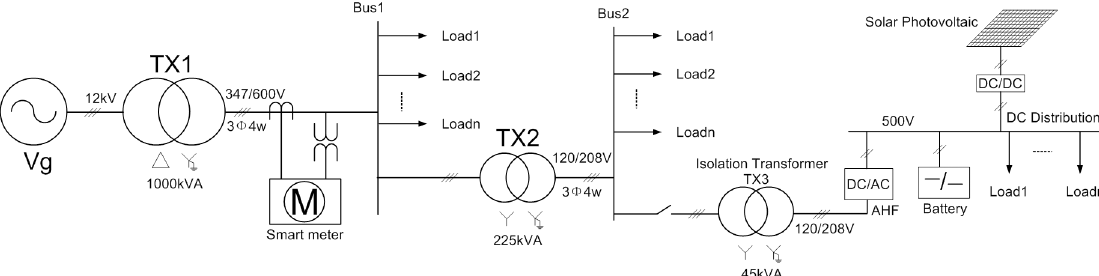
Fig 1. Configuration of the DG system in the representative educational Building.